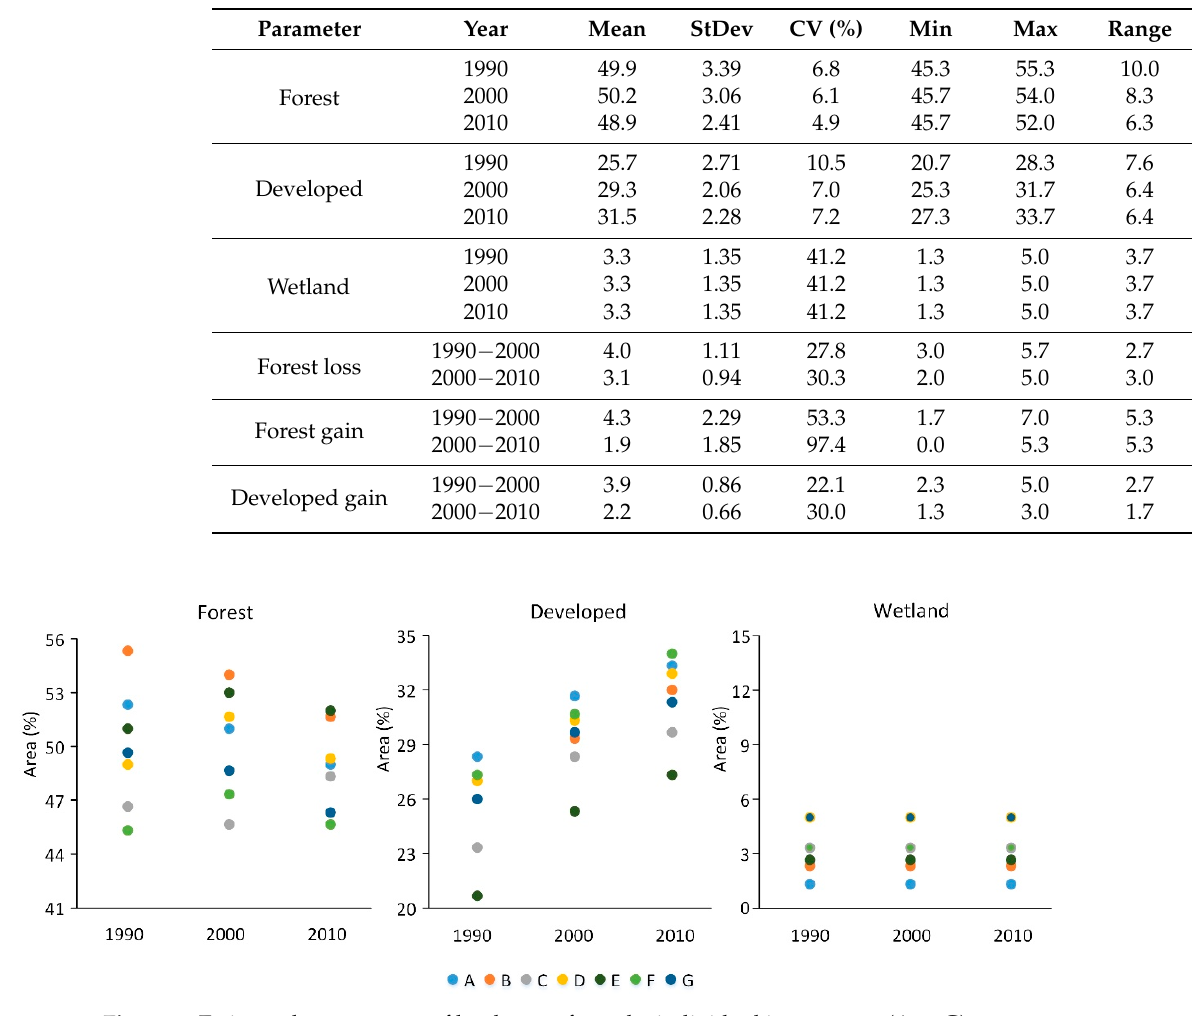
Figure 2. Estimated percent area of land cover from the individual interpreters (A to G).